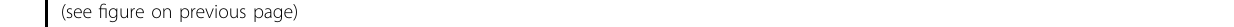
Fig. 2 Effects of protease cleavage on viral infectivity. a Amino acid alignment of the protease cleavage site for SARS-CoV-2, PCoV-GD, PCoV-GX, and RaTG13. The recognition sequences were embraced in boxes and cleavage sites indicated with triangles. b Pseudoviruses produced in cells overexpressing different proteases. Most of SARS-CoV-2 S were cleaved into S1 and S2. The ratio of the cleaved form increased slightly in Furin and TMPRSS2. The other three pseudoviruses present the S on their surface mostly in intact forms. c Relative infectivity of the pseudoviruses in hACE2 cells and hACE2 cells with various overexpressed proteases. d The entry of SARS-CoV-2, PCoV-GD, and PCoV-GX into cell lines expressing different proteases was blocked with three protease inhibitors, Decanoyl-RvKR-CMK for Furin, Camostat for TMPRSS2, and E64D for Cathepsin L inhibitor. All results were obtained from three independent experiments (mean± SEM). In each experiment, the infection assay was performed in duplicate